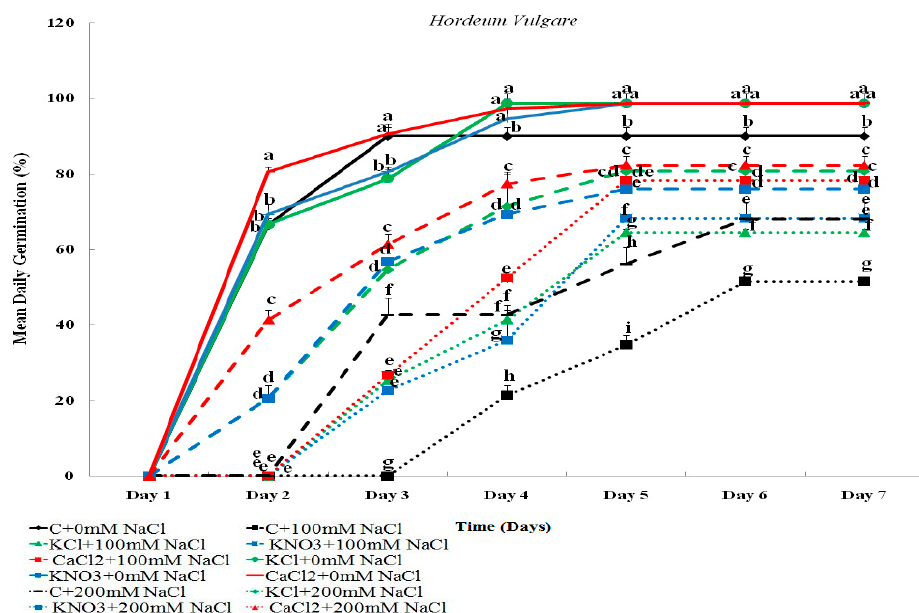
Figure 2. Effect of KCl, KNO 3 , and CaCl 2 seed priming on the mean daily germination (MDG) in Hordeum maritimum and Hordeum vulgare (L. Manel) subjected to various salt concentrations (0, 100, and 200 mM NaCl) for 7 days at the germination stage. Values are means of 20 replicates ± standard error. Data with the same letter are not significantly different at p < 0.05 (Duncan’s test).